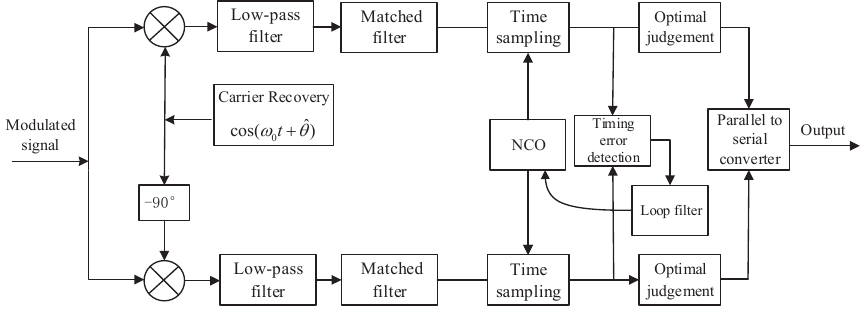
Figure 7. Block diagram of the partial-respond coherent demodulation. NCO: numerical control